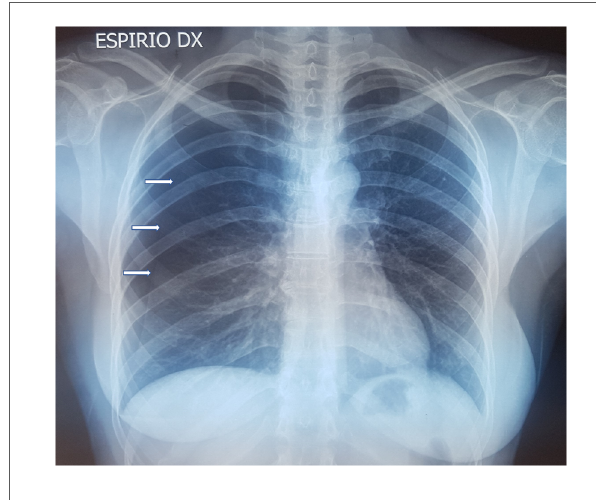
FIGURE 1 Chest x-ray showing CP on the right side: white arrows indicate the collapsed lung. CP, catamenial pneumothorax.